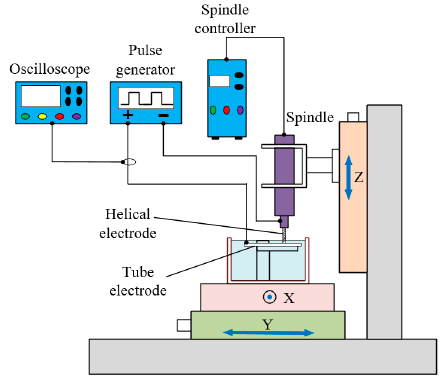
Figure 3. Experimental setup for ECMD.